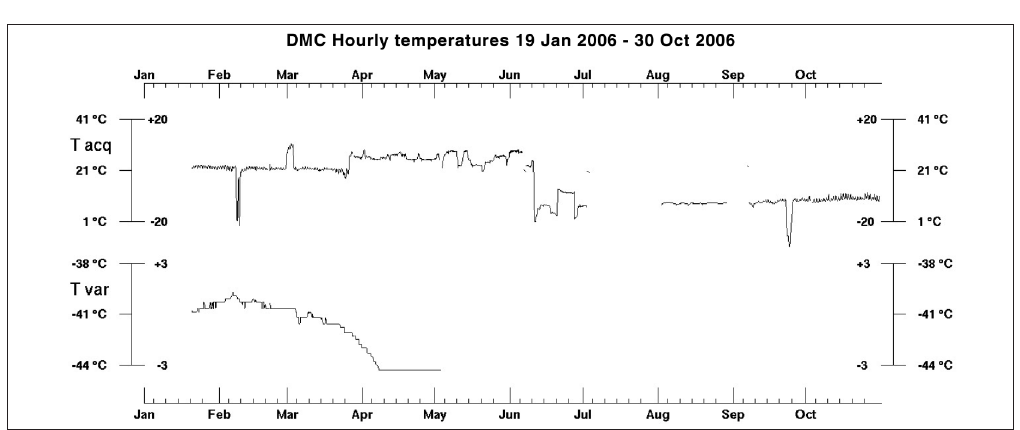
Fig. 8. Top: Hourly mean temperature record in the box housing the instrument electronics and acquisition de- vice. There are mainly two parts, before and after the door of the box was left open (mid June 2006 onwards). See Section 4 for details regarding the additional jumps and peaks. Bottom: Hourly mean temperature record in the cave, close to the magnetometer. The temperature drops to values lower than -44°C, which is the lower lim- it of the data logger recording